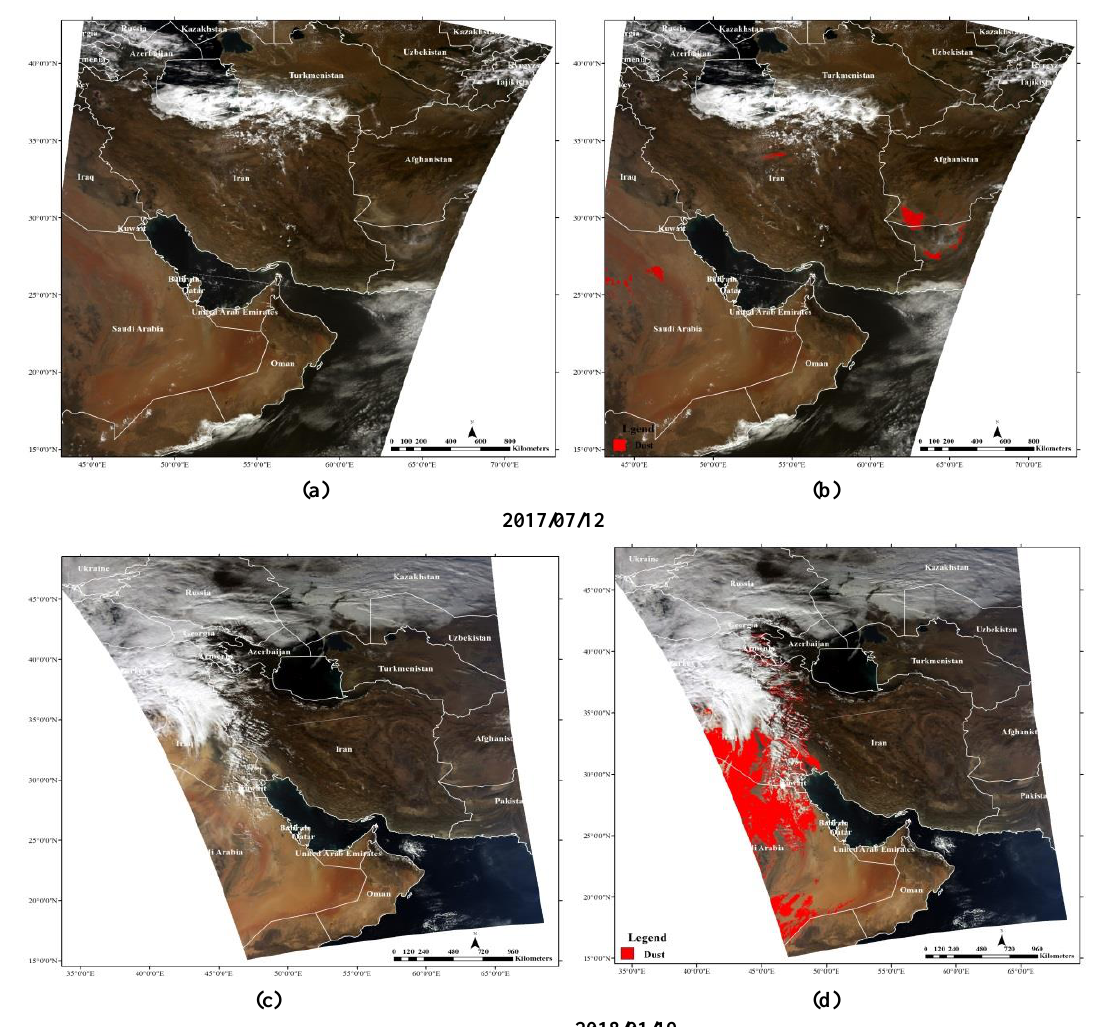
Figure 4. MODIS true color images ("a" and "c") The results of the proposed algorithm ("b" and